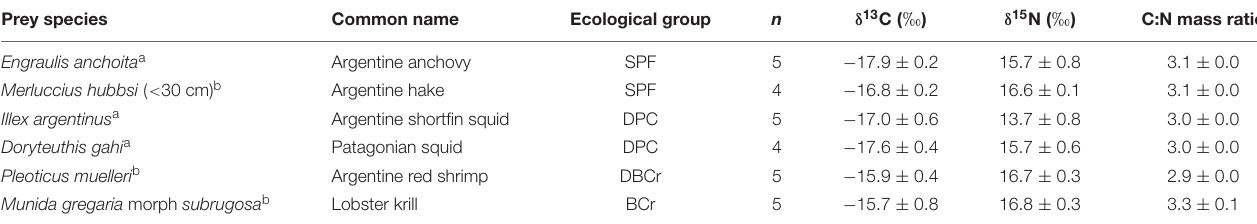
TABLE 1 | Stable isotope ratios of carbon ( δ 13 C) and nitrogen ( δ 15 N), and the C:N mass ratio (mean ± SD) of the main prey of South American fur seals. Prey species